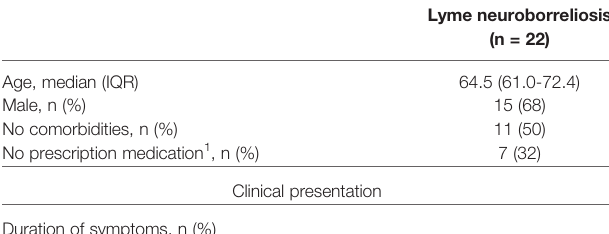
TABLE 1 | Baseline characteristics of 22 patients with Lyme neuroborreliosis at time of fi rst blood